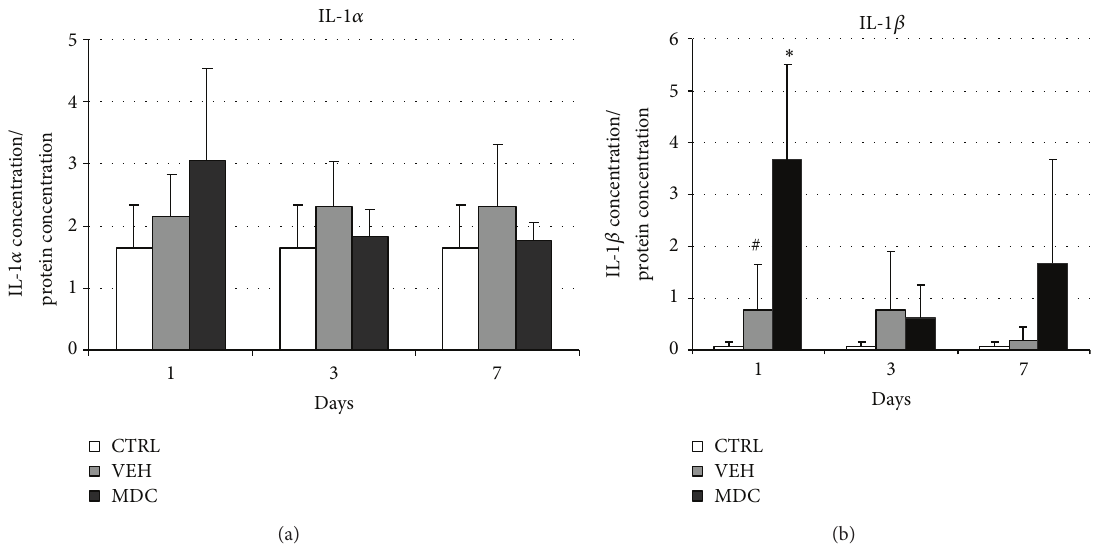
Figure 3: The concentration of cytokines: IL-1 𝛼 (a), IL-1 𝛽 (b) in the muscle tissue: untreated control (CTRL), after vehicle injection (VEH), and after MDCs transplantation (MDC) 1, 3, and 7 days after surgery. Protein concentrations of cytokines in tissue were determined using ELISA tests. Results were analyzed in pairs (untreated control versus VEH and VEH versus MDC) using nonparametric U Mann-Whitney test. ∗ indicate statistically significant difference between MDC and VEH groups and # indicate statistically significant difference between VEH and CTRL groups in certain time points.